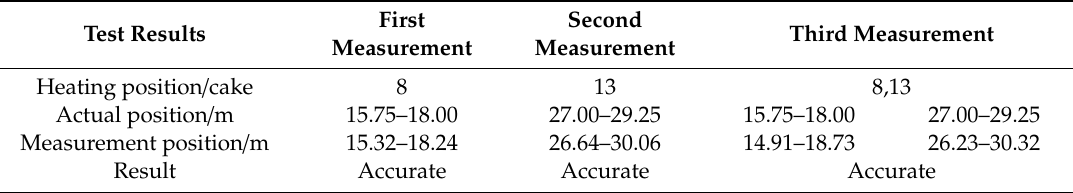
Table 5. Comparison of winding hot-spot positioning results.